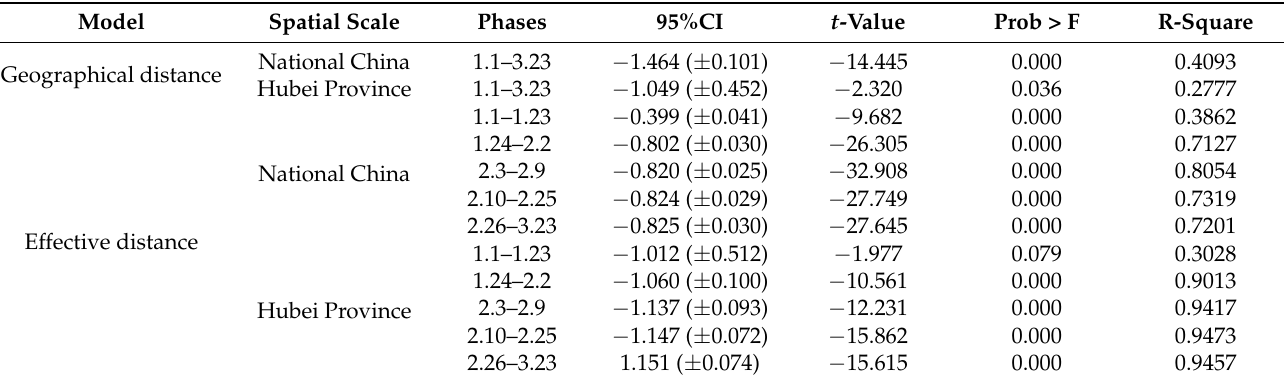
Table 4. The results of linear regression